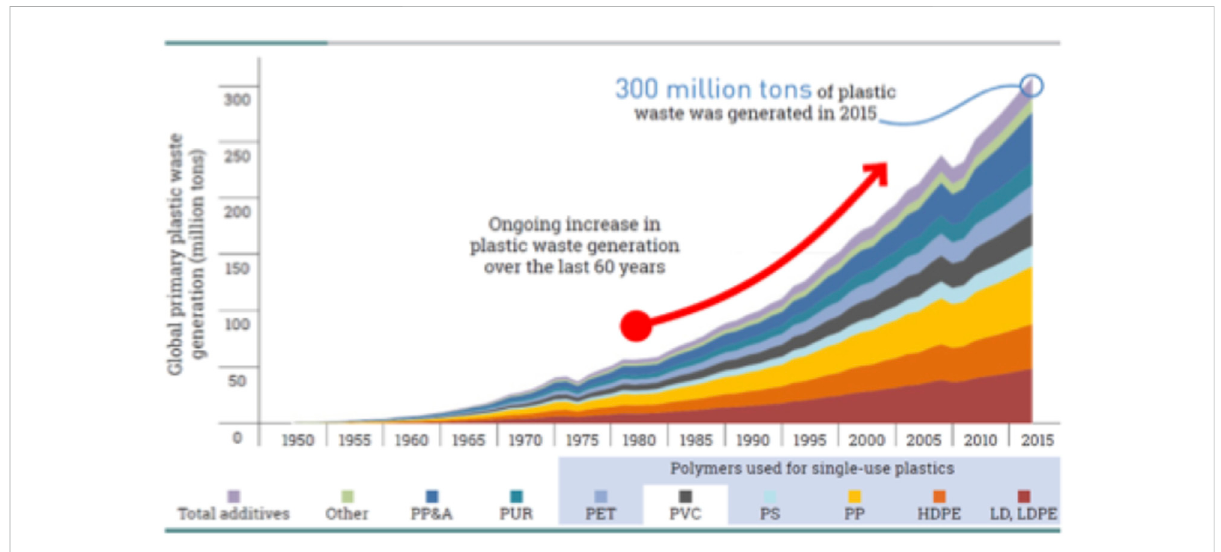
FIGURE 1 Universal main plastics-waste production, 1950 –